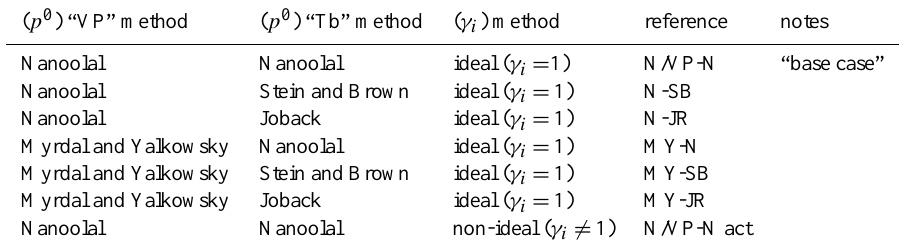
Table 1. Combinations of ( p 0 ) and ( γ i ) predictive techniques used within absorptive partitioning